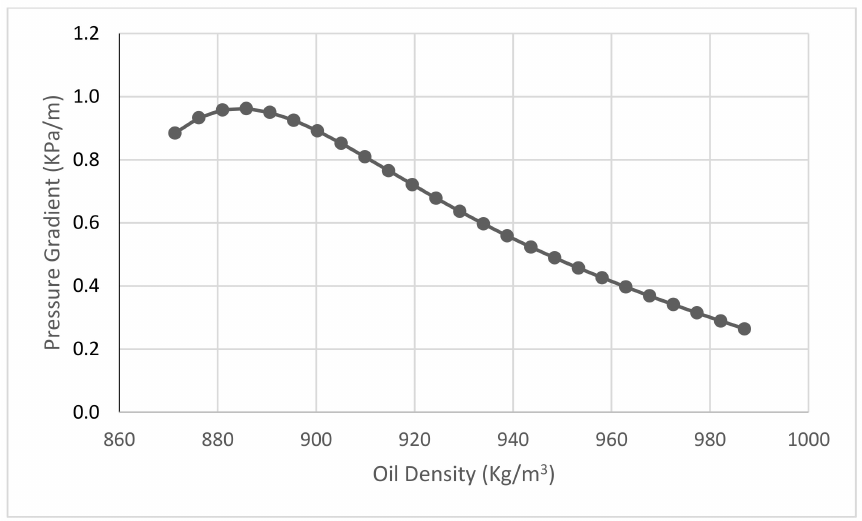
Figure 11. Effect of oil density.